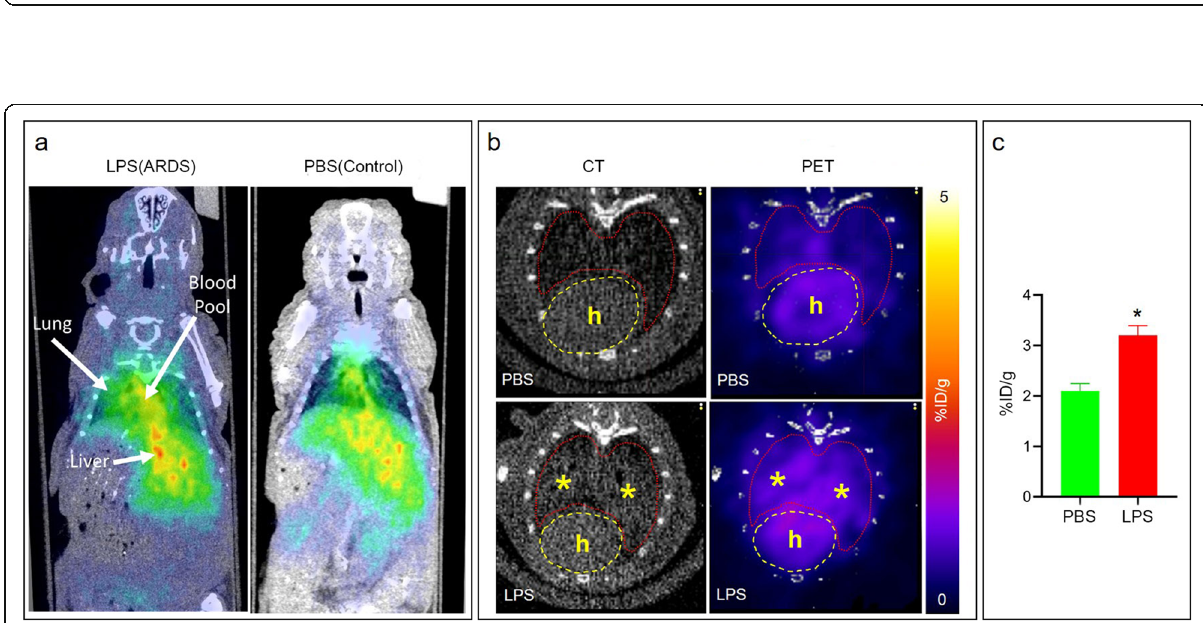
Fig. 3 Dynamic 4 h PET imaging after injection of 68 Ga-albumin. a representative coronal images of a 240 min dynamic 68 Ga-albumin PET scan in an untreated B6 mouse ( n = 4). b dynamic 68 Ga-albumin activity in the heart, liver and lungs of untreated B6 mice ( n = 4). c biodistribution of 68 Ga-albumin in tissues of untreated B6 mice ( n = 4) ~ 4.5 h after injection